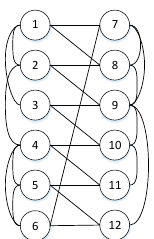
Figure 3. Instance with n = 12 nodes for survivability where Networks A and B have both six nodes.